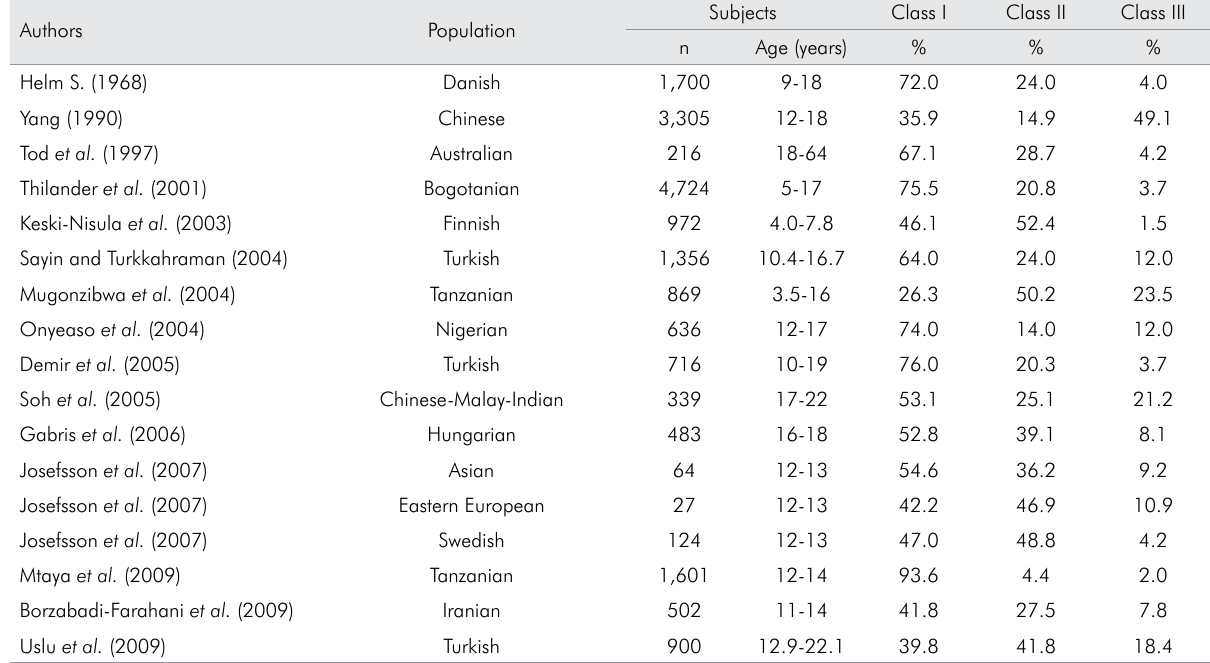
Table 3. Prevalence (percent) of malocclusion in children and adolescents in different ethnic